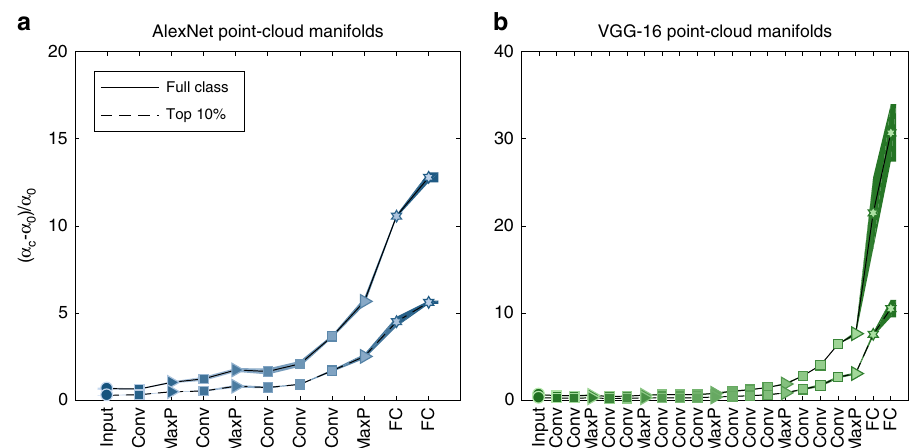
Fig. 4 Capacity of point-clouds manifolds of ImageNet classes. a , b Normalized classi fi cation capacity for point-cloud manifolds of ImageNet classes (full line: full class manifolds; dashed line: top 10% manifolds) along the layers of AlexNet ( a ) and VGG-16 ( b ). AlexNet top 10% manifolds results already appeared as “ after training ” results from Fig. 3e. Line and markers indicate mean value over 5 different choices of 50 objects; surrounding shaded areas ¼ 2 = < M M μ denotes the indicate 95% con fi dence interval. Capacity is normalized by α μ > μ , the value expected for unstructured manifolds (see main text; c number of samples from object μ ). The x -axis labels provides abbreviation of the layer types. Marker shape represents layer type (circle — pixel layer, square — convolution layer, right-triangle — max-pooling layer, hexagon — fully connected layer). Features in linear layers are extracted after a ReLU nonlinearity. Color (blue — AlexNet, green — VGG-16) changes from dark to light along the network.